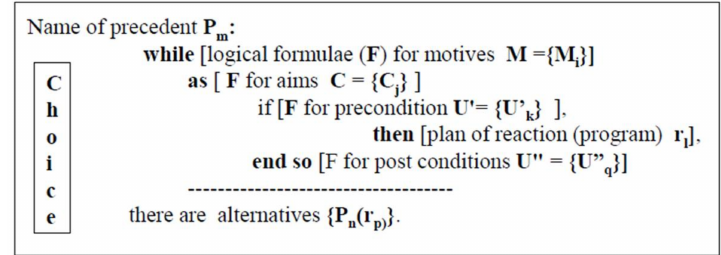
Figure 10. Logical model of